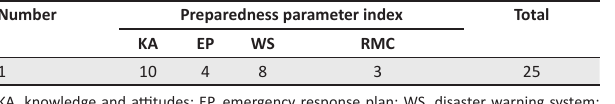
TABLE 6b: Maximum weight data per